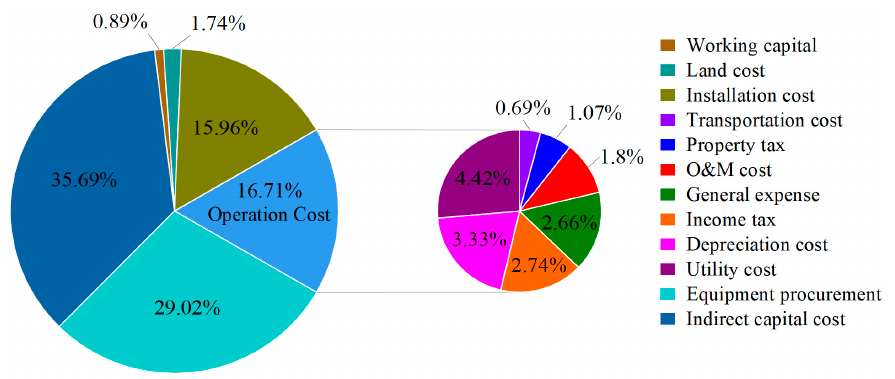
Figure 8. Economic cost breakdown for the proposed green poly-generation integrated system.